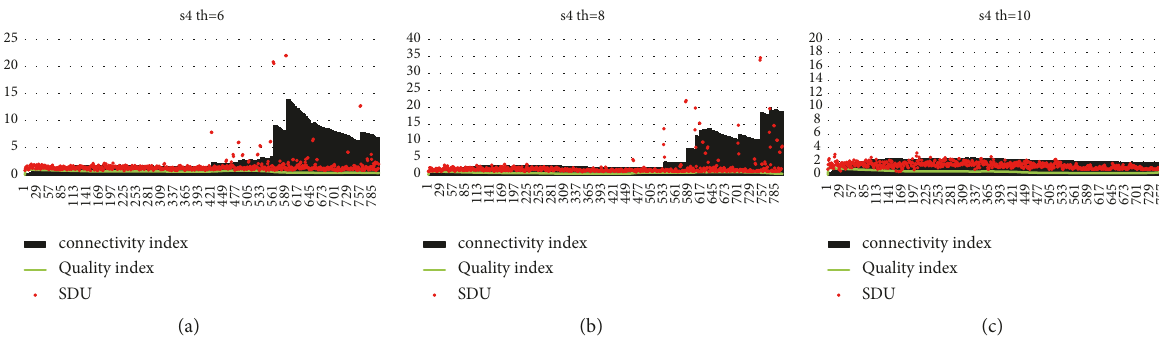
Figure 9: Phase shift analysis. Each graph above shows a time-series plot of 800 hours. Quality index is shown through green line. The SDU is shown through red points, and quality index is shown through bars fillings in black. (a) 𝑡ℎ 𝑠𝑡𝑟𝑜𝑛𝑔−𝑡𝑖𝑒 = 6 , resources = 15, (b) 𝑡ℎ 𝑠𝑡𝑟𝑜𝑛𝑔−𝑡𝑖𝑒 = 8 , resources = 10, and (c) 𝑡ℎ 𝑠𝑡𝑟𝑜𝑛𝑔−𝑡𝑖𝑒 = 10 , resources = 10. These graphs correspond to 550 vehicles.